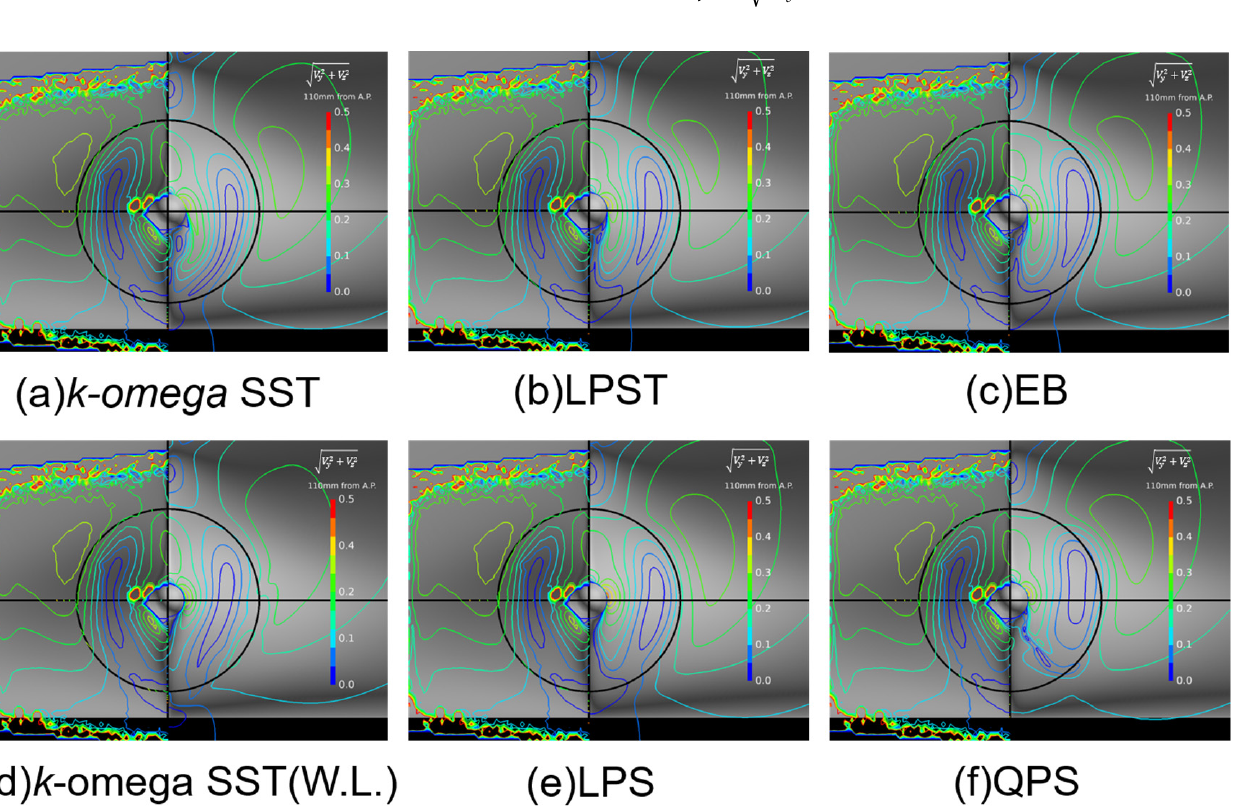
Figure 8. Crossflow distribution of SPIV (Left) and CFD (Right) at 110 mm from AP to bow side. ( a ) k –omega SST ( b )LPST ( c )EB ( d ) k –omega SST (W.L.) ( e )LPS ( f )QPS The contour at V cf = 0.05 obtained using the k –omega SST model is located